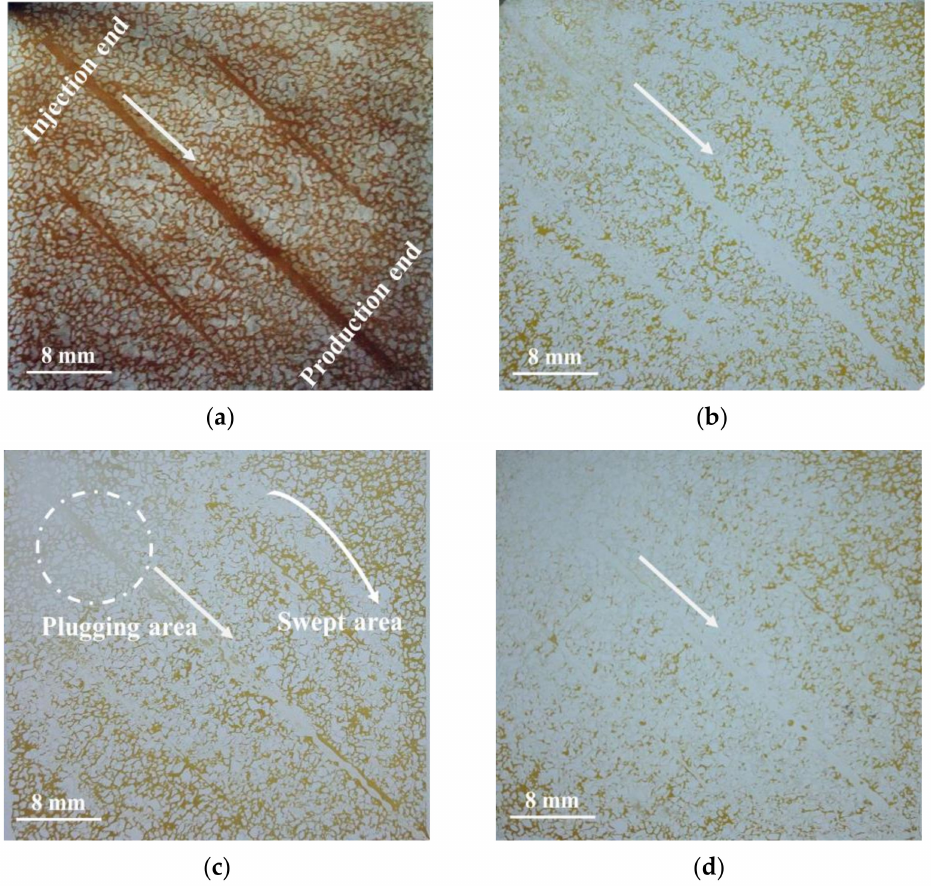
Figure 13. Distribution of the crude oil at different stages of the microscopic flooding experi- ment: ( a ) initial oil saturation; ( b ) residual oil after waterflood; ( c ) residual oil after the injection of